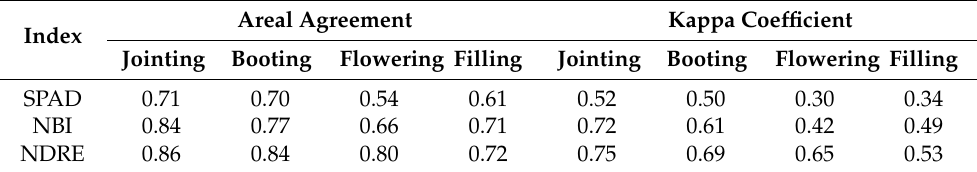
Table 6. Areal agreement and kappa coefficient for SPAD, NBI, and NDRE at different growth stages.